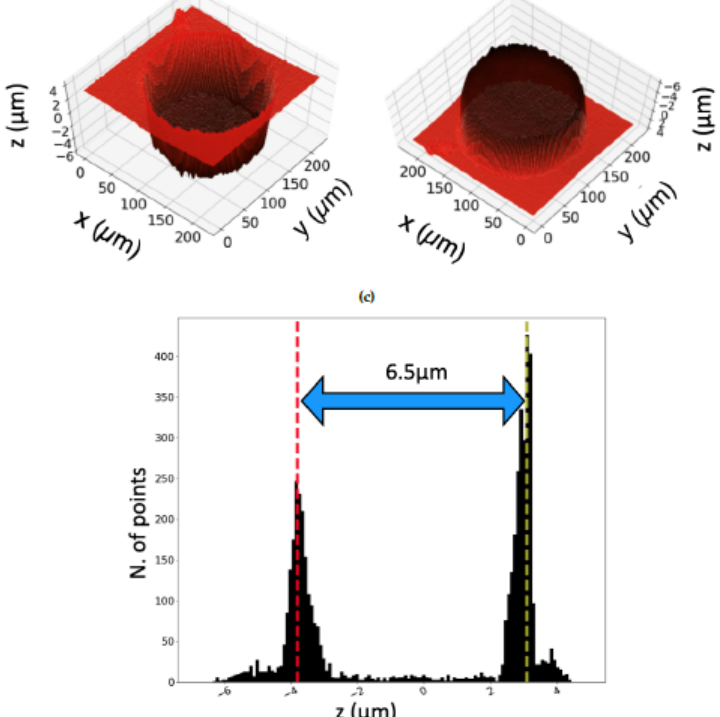
Figure 5. 3D rendering of ( a ) the dimple and ( b ) its bottom. In ( c ), the histogram presenting the distribution of the height levels in ( a ) is shown. The distance between two peaks, being equal to 6.5 µ m, represents the depth of each